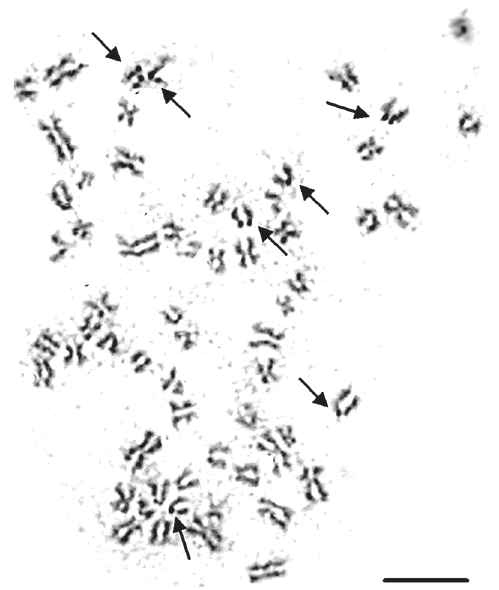
Figure 4. Chromosomes of W. pyrrhorhinus from Fazenda Salinas, Morro do Chapéu, Bahia: chromosomal distribution of Ag-NOR sites (arrows). Scale bar = 10